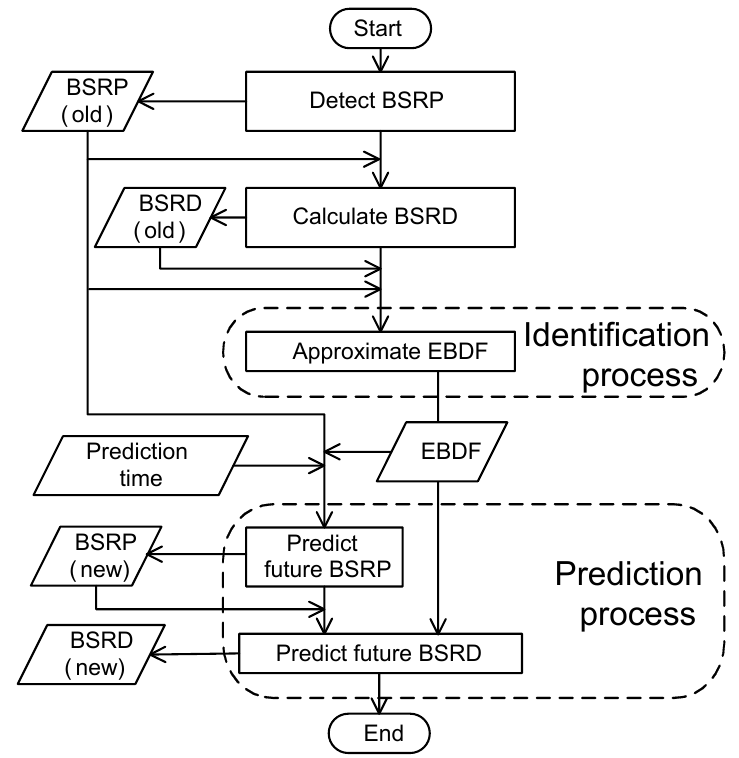
Figure 5. Flow of the proposed prediction